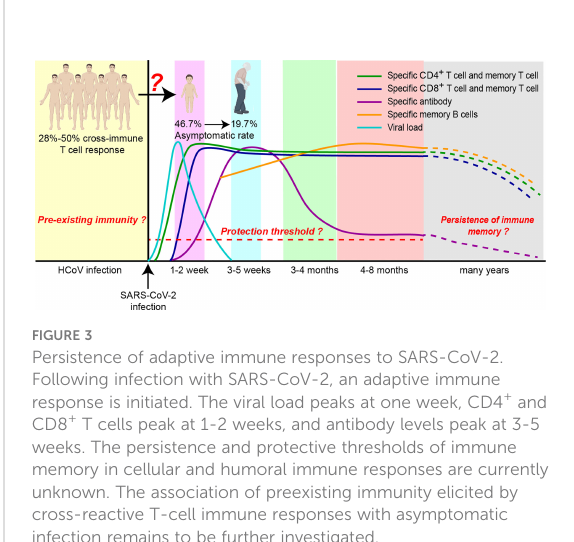
FIGURE 3 Persistence of adaptive immune responses to SARS-CoV-2. Following infection with SARS-CoV-2, an adaptive immune response is initiated. The viral load peaks at one week, CD4 + and CD8 + T cells peak at 1-2 weeks, and antibody levels peak at 3-5 weeks. The persistence and protective thresholds of immune